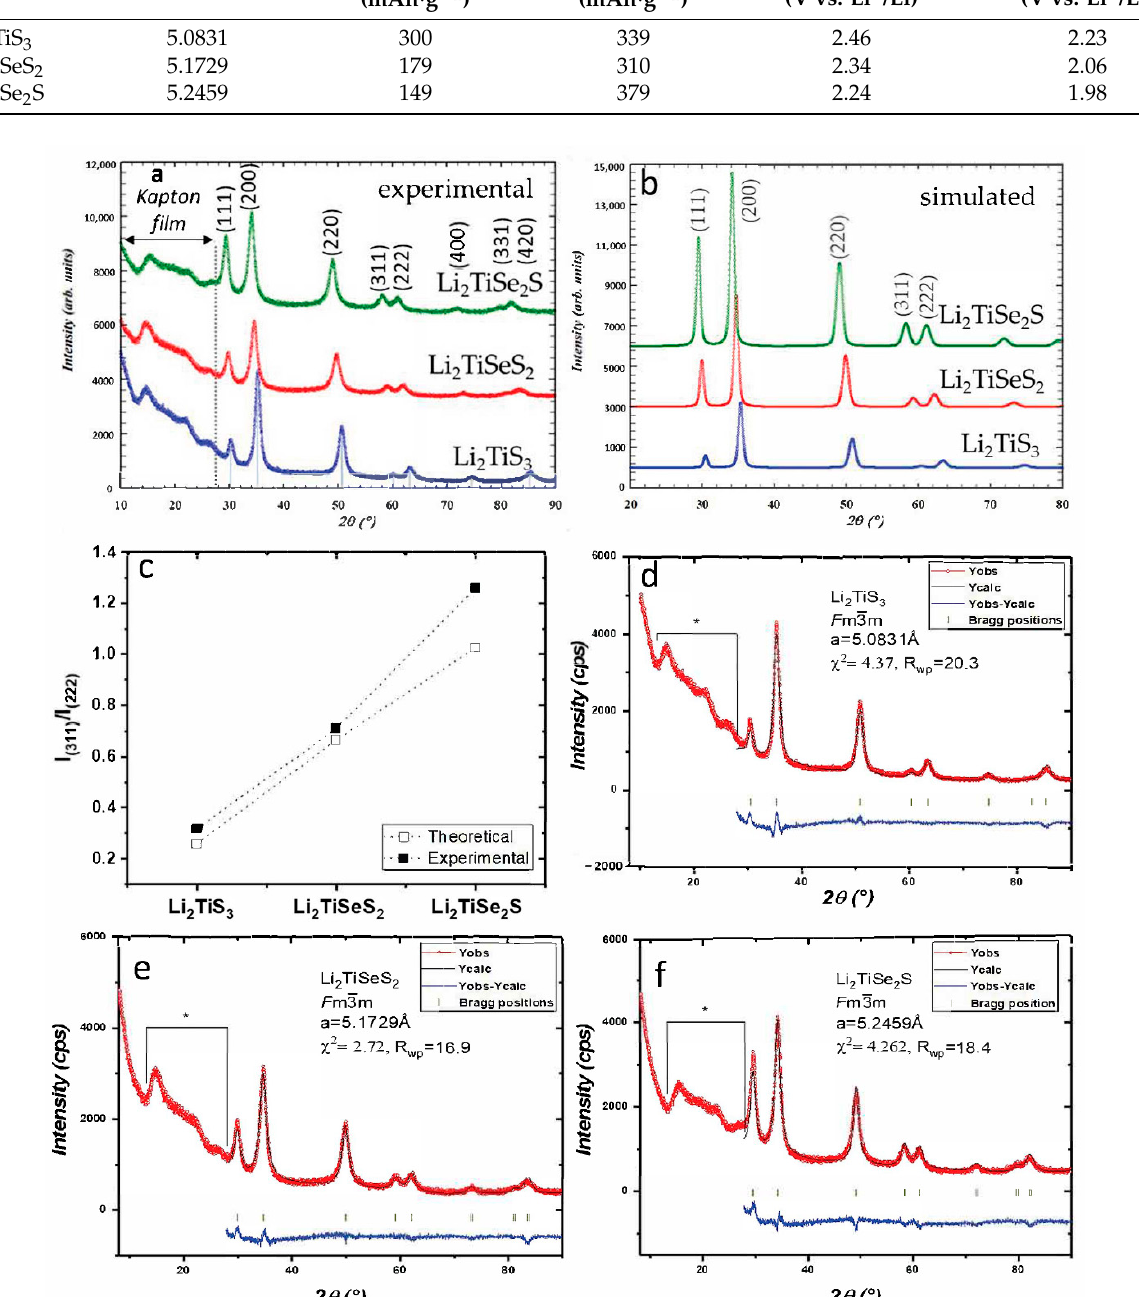
Figure 1. ( a )/XRD patterns of Li 2 TiSe x S 3 − x (0 ≤ x ≤ 2) materials—( b )/Simulated XRD patterns of Li 2 TiSe x S 3 − x powders and ( c )/experimental and simulated peak intensity ratio of (311) and (222) planes, I (311) /I (222) for Li 2 TiS 3 , Li 2 TiSeS 2 , and Li 2 TiSe 2 S powders—( d – f )/XRD pattern of Li 2 TiSe x S 3 − x (0 ≤ x ≤ 2) Rietveld refinement in the Fullprof program. Brackets with asterisk indicate the zone where the protective Kapton ® foil signal prevented the refinement from being carried out.